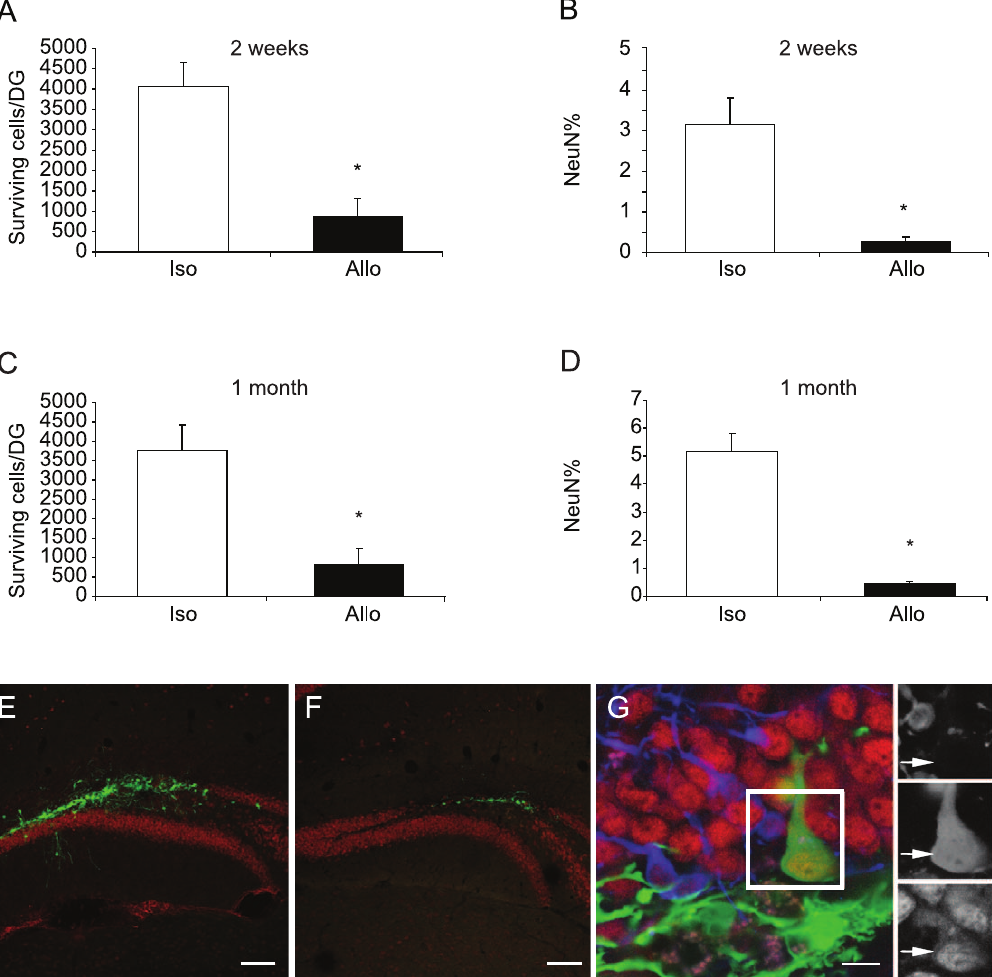
Figure 1. Survival and neuron production is reduced in allografts . C57BL/6 GFP-positive NPCs were transplanted into C57BL/6 or Balb/c mice. Two weeks or one month later, brains were harvested and analyzed for survival and differentiation of the grafts. ( A–D ) The number of surviving cells per DG and the proportion of these cells expressing a mature neuronal marker (NeuN + ) were scored. Survival and neuron production were significantly lower in allografts. * p , 0.05, n=5, compared with isografts. ( E–G ) Representative pictures of isograft (E), allograft (F) and mature NeuN + neurons derived from NPC grafts (G). Green, GFP; Red, NeuN; Blue, Dcx. Scale bars, 100 m m (E and F) and 10 m m (G). For all figures in this study, S.E.M is indicated by error